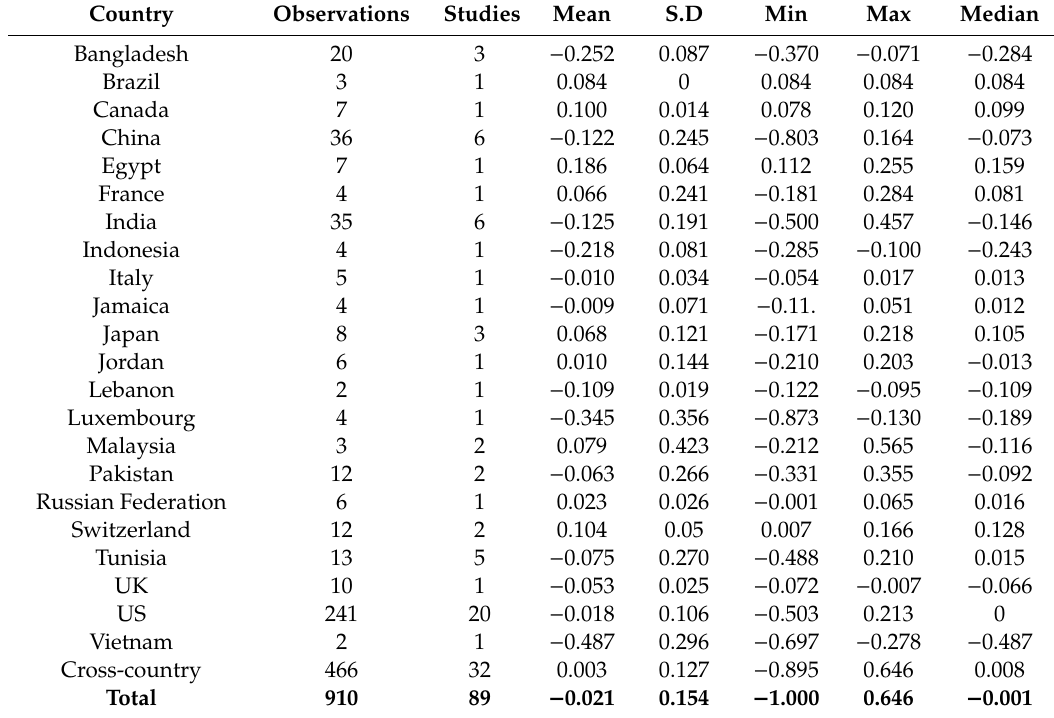
Table 1. Standardized effects of bank capital on risk (partial correlation coefficient—PCC) across countries.